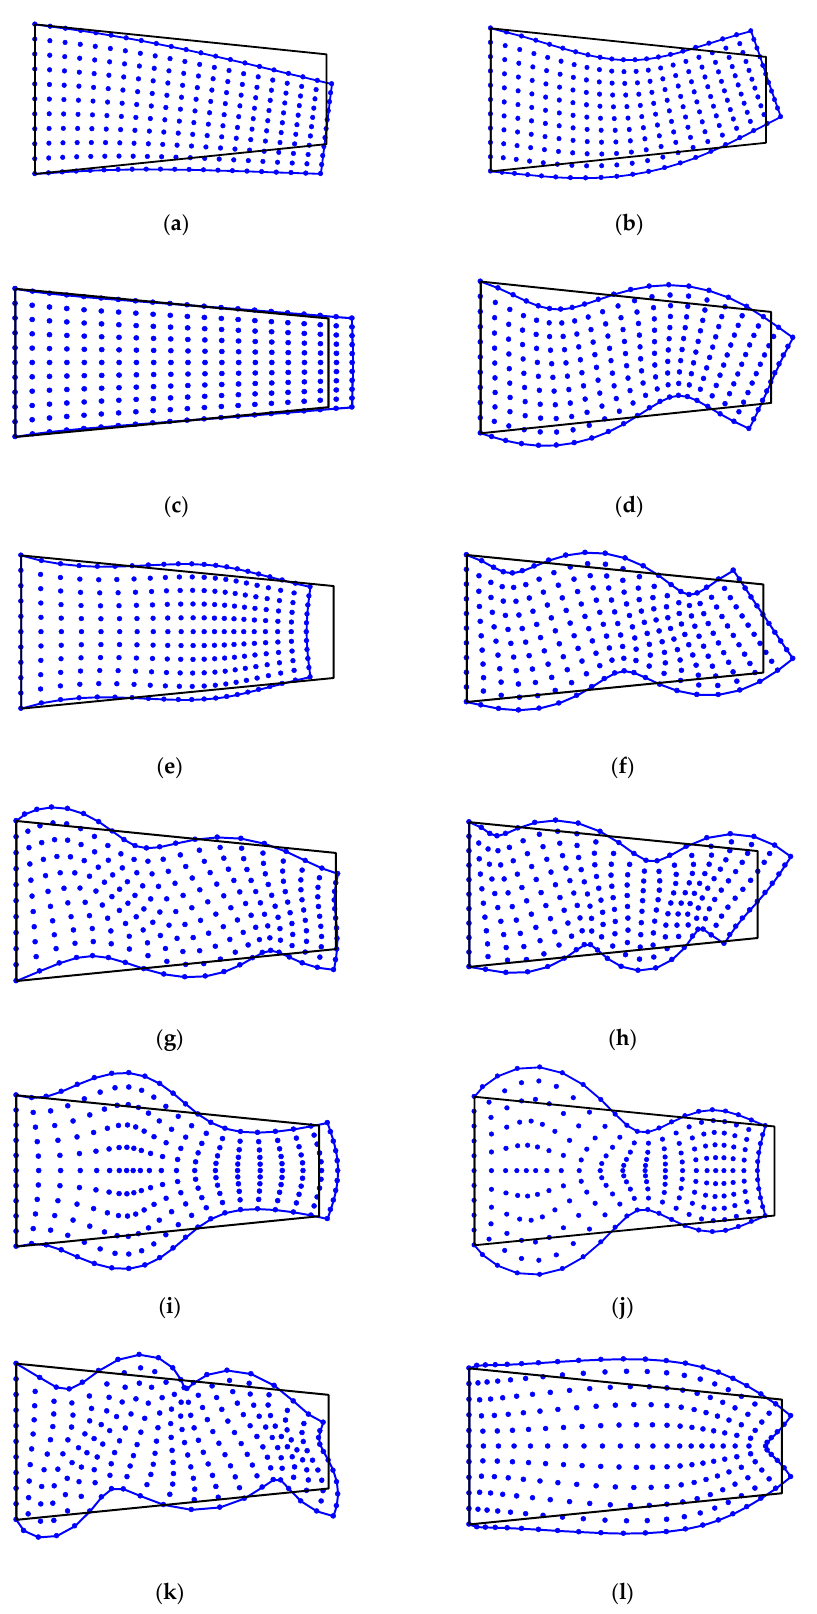
Figure 9. The free vibration modes of the variable cross-section cantilever beam corresponding